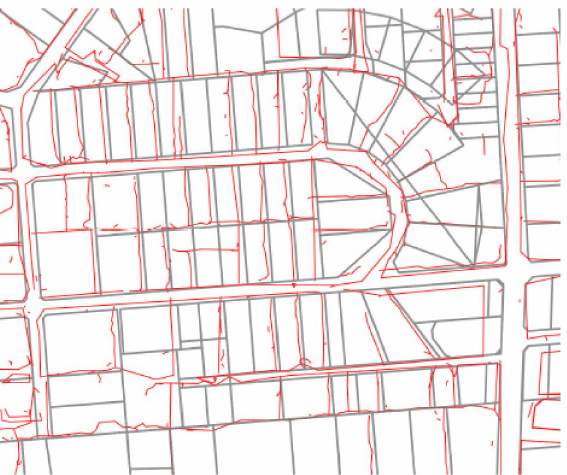
Figure 8. The 2000s saw convergence in data capture technologies and integrated workflows for map production, as demonstrated by [257], where lidar data, aerial imagery, and open-source software were used to generate a parcel layer (red lines) with limited human input. Note: grey lines are the original cadastral boundaries, used for